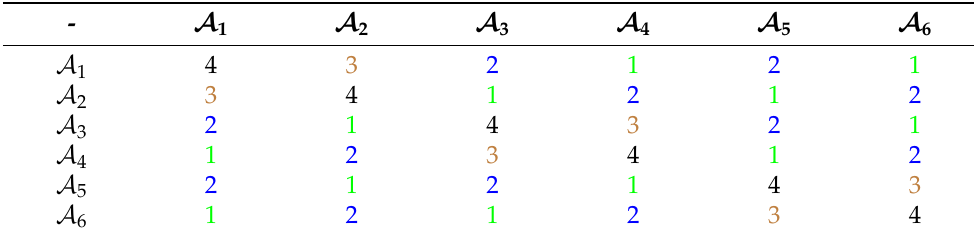
Table 1. The minimum number of crossings between two different subgraphs T i and T j such that conf ( F i ) = A k and conf ( F j ) = A l , where the achieved values are color-coded. Namely, the values 1, 2, 3, and 4 will correspond to green, blue, brown, and black,